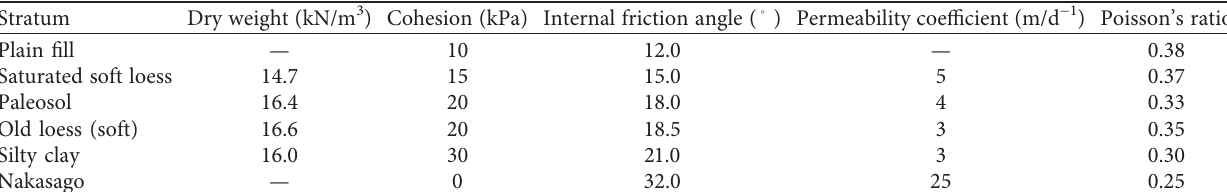
Figure 3: Underground diaphragm wall structure design (unit: m). Table 1: Physical and mechanical parameters of